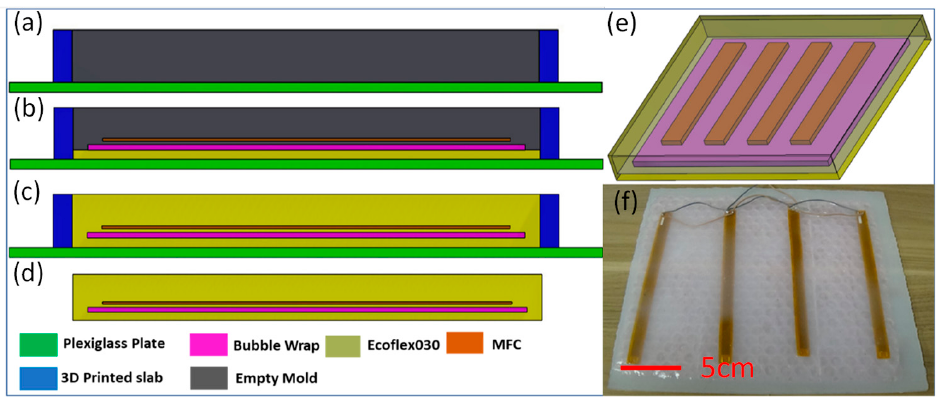
Figure 2. Fabrication steps, schematic, and photographic image of the OWEC (figure not to scale). ( a ) The empty mold. ( b ) A thin layer of Ecoflex was dispensed in the mold and the bubble wrap and MFC were placed on top of this layer. ( c ) A further layer of Ecoflex was dispensed over the MFCs and bubble wrap, and the mold was filled. ( d ) The Ecoflex was cured and the OWEC finalized. ( e ) 3D schematics of the OWEC, showing the bubble wrap and the MFCs. ( f ) Photographic image of the final OWEC.